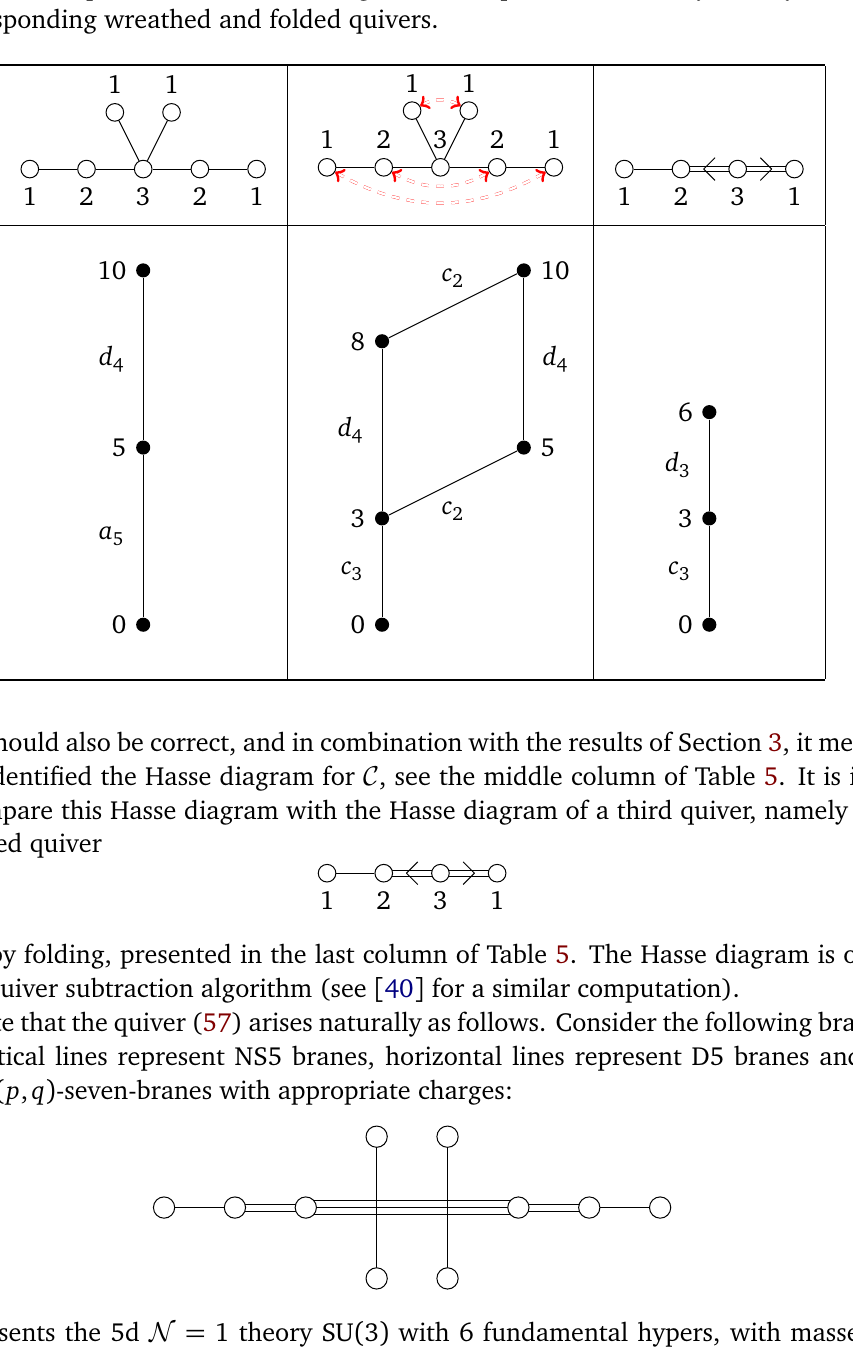
symmetry and the 2